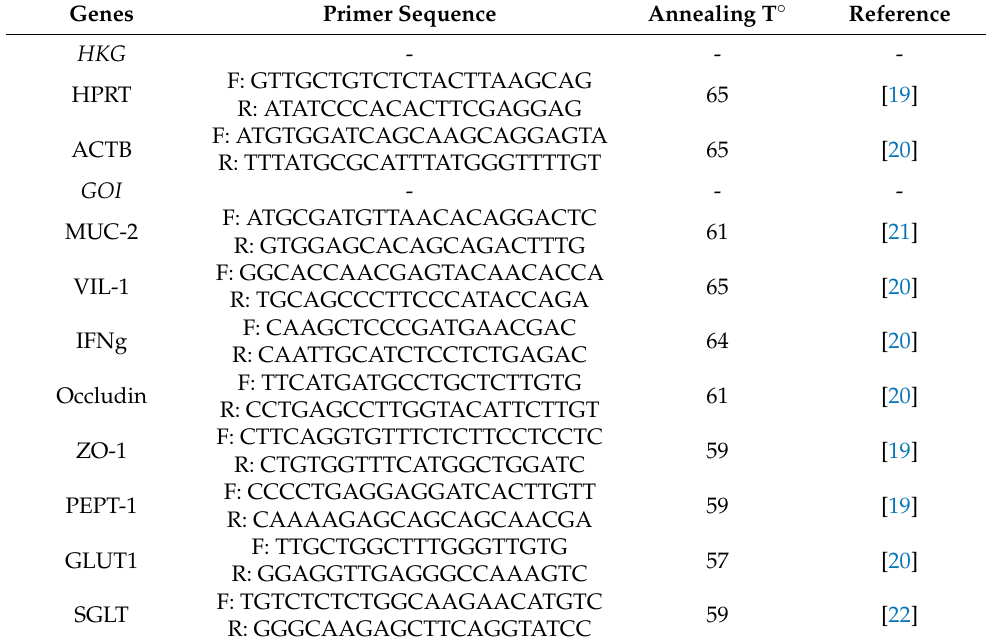
Table 3. Primers used for the expression quantification of housekeeping genes (HKG) and genes of interest (GOI).